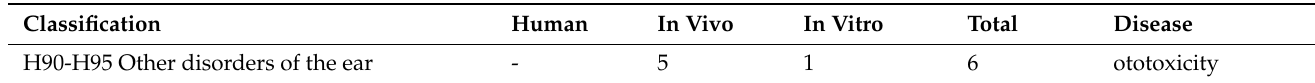
Table 17. The statistics of pharmacological results and its major diseases of SMC by experimental type in VIII Diseases of the ear and mastoid process of ICD-10.